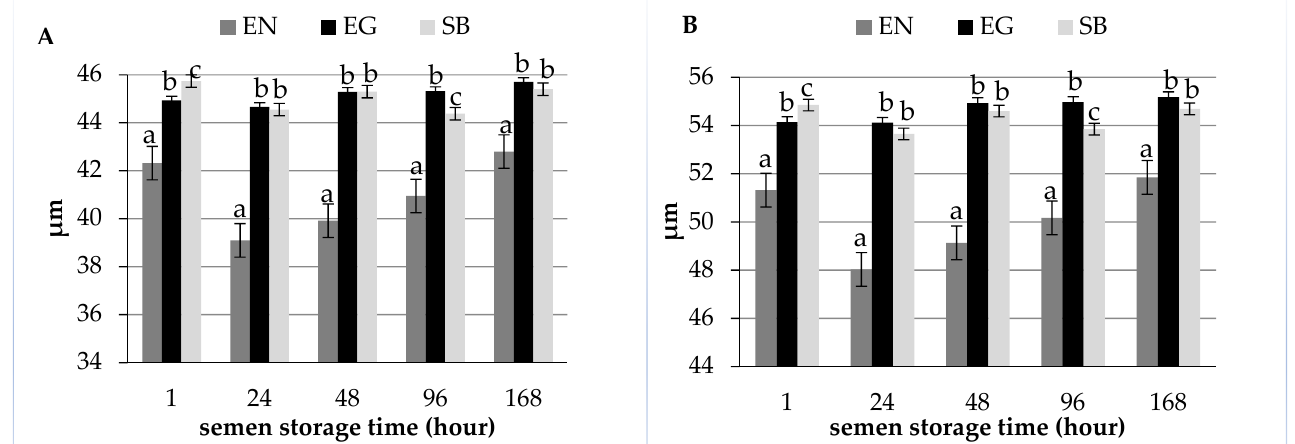
Figure 2. Length of sperm stained by the eosin-nigrosin (EN), eosin-gentian (EG), and SpermBlue (SB) methods depending on semen storage time (( A )—tail length, ( B )—total sperm length). Bars with different letters mean statistically significant values ( p ≤ 0.05).